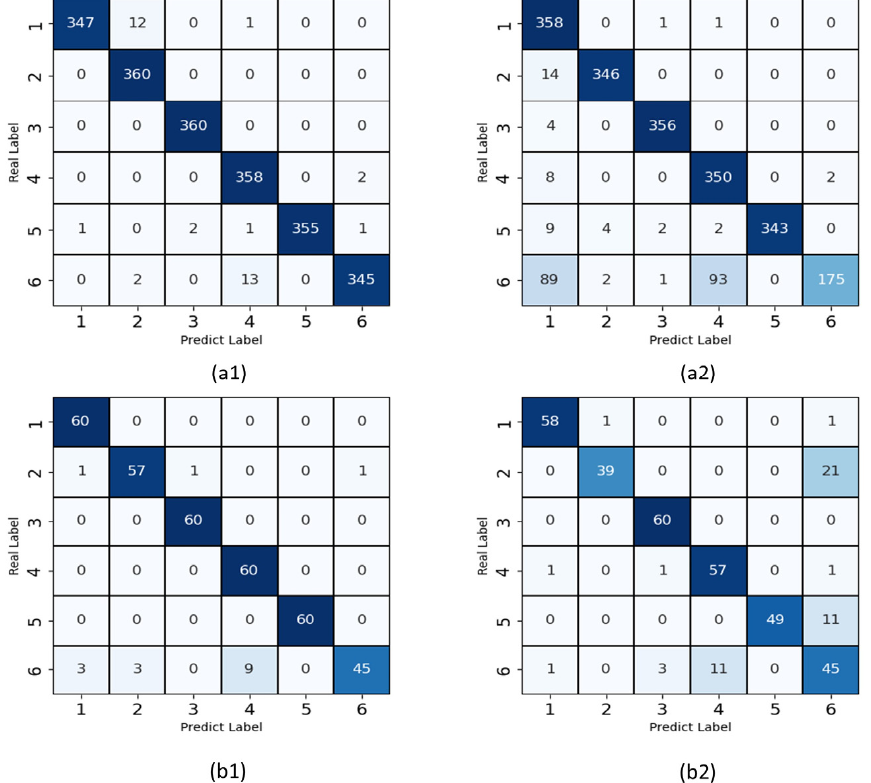
Figure 6. Comparison of confusion matrices. ( a1 , a2 ) are the training models with maximum and